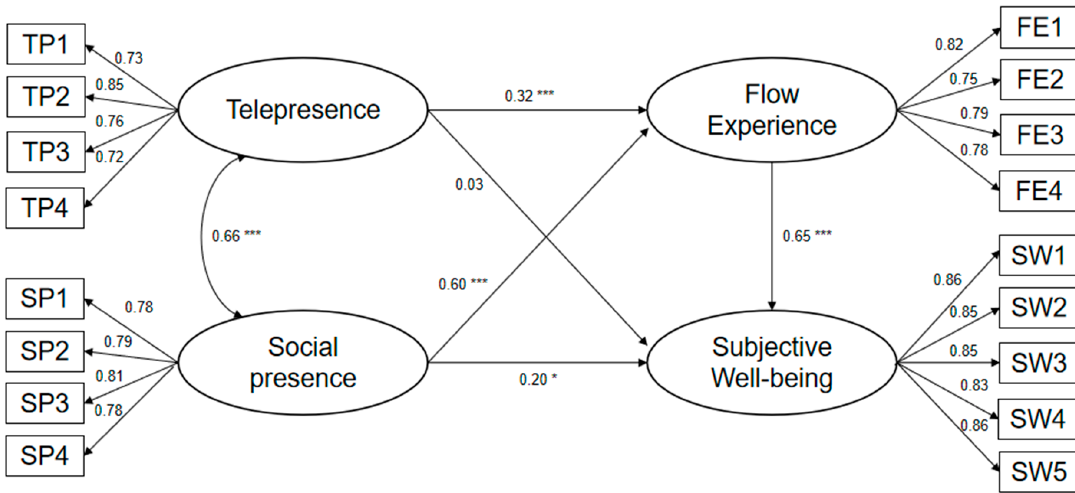
Figure 3. Results of structural model testing. *** Significance at the 0.001 level; * significance at the 0.05